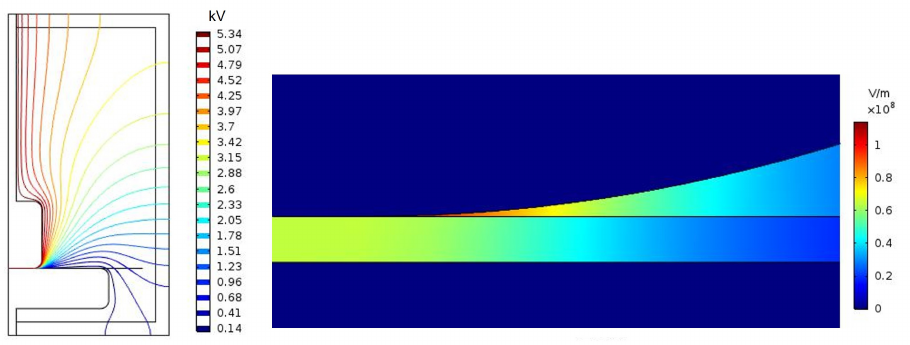
Figure 9. Finite element simulation of the test cell for the NF-impregnated paper immersed in NF.